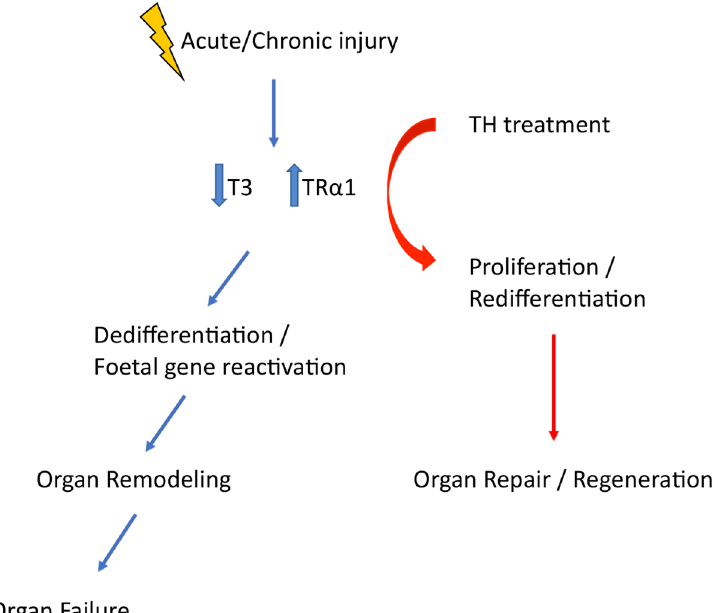
Figure 2. Acute of chronic injury is followed by an adoption of a foetal TH signalling profile which triggers dedifferentiation and foetal gene reactivation. Manipulation of TH signalling timely is a therapeutic opportunity that can enhance tissue repair and regeneration. .